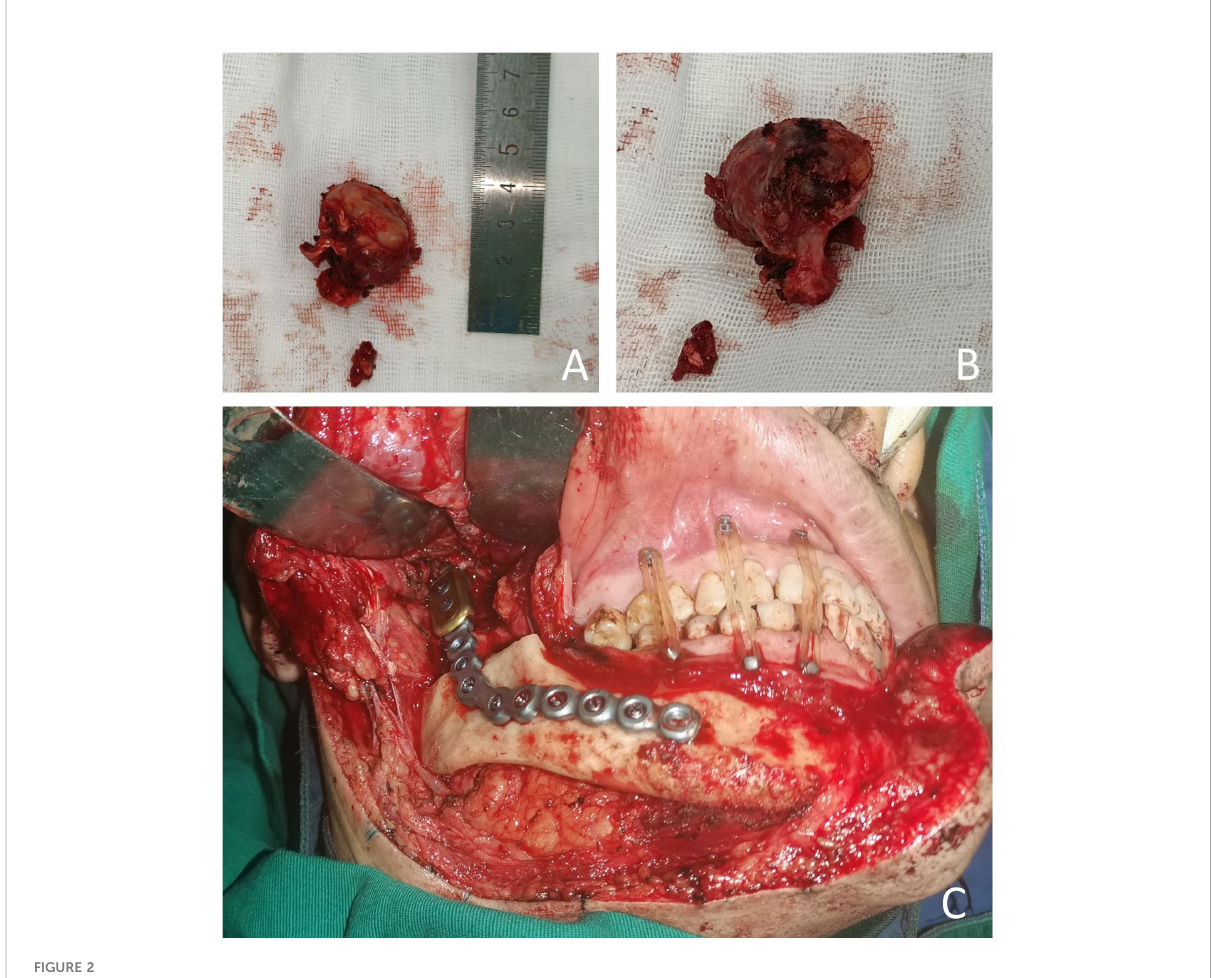
FIGURE 2 Imaging of surgical procedure (A – C)